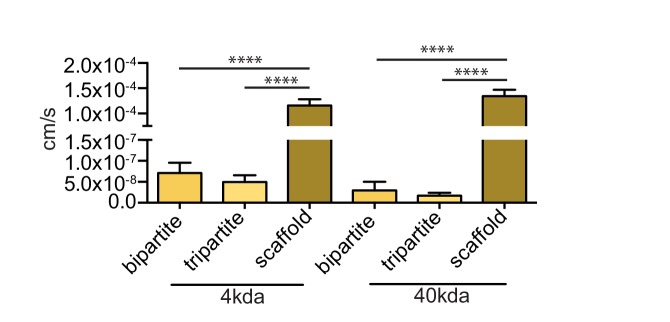
Endothelia of bioengineered vessels are impermeable to FITC-dextran.Barrier integrity was assessed by measuring permeability of 250 μg/ml of 4 kDa or 40 kDa FITC-dextran circulated through the lumen for 1 hr. Graphs represent mean ±SEM for at least three independent tissues. ****p=0.0001.